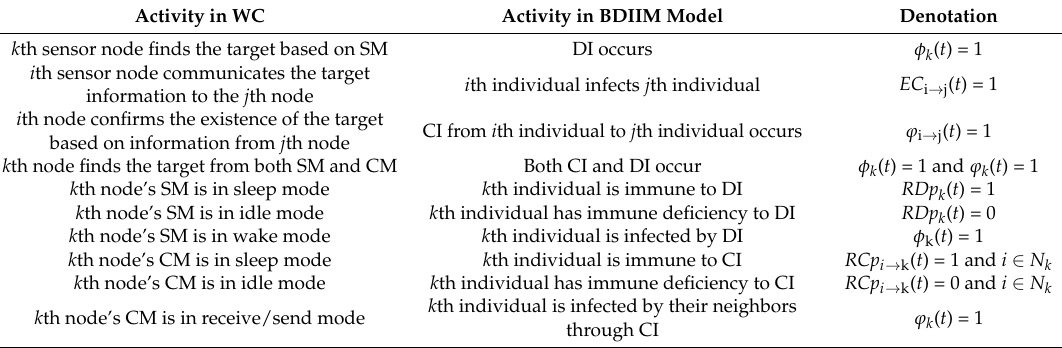
Table 2. Corresponding activity relationships between the k th node and the individual.